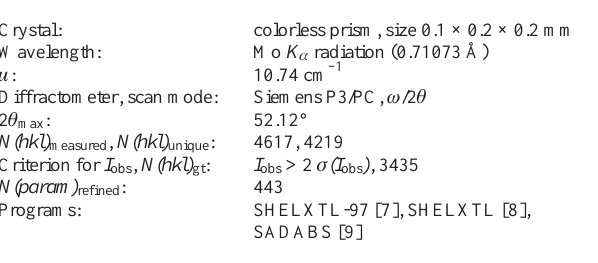
Table 1. Data collection and